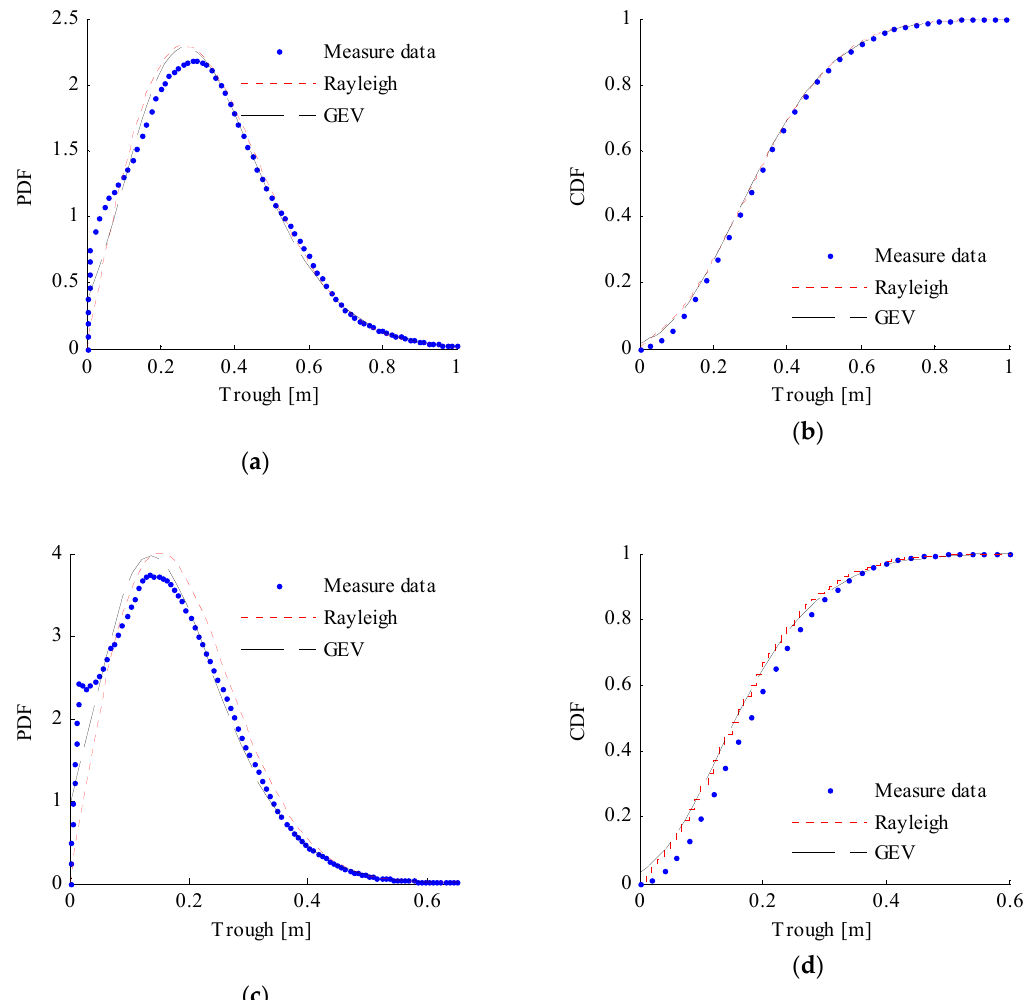
Figure 12. Computed PDF and CDF for the trough height of the measured data, and Rayleigh and GEV distributions: ( a ) trough height PDF when H s = 1.0583 m; ( b ) trough height CDF when H s = 1.0583 m; ( c ) trough height PDF when H s = 0.6069 m; and, ( d ) trough height CDF when H s = 0.6069